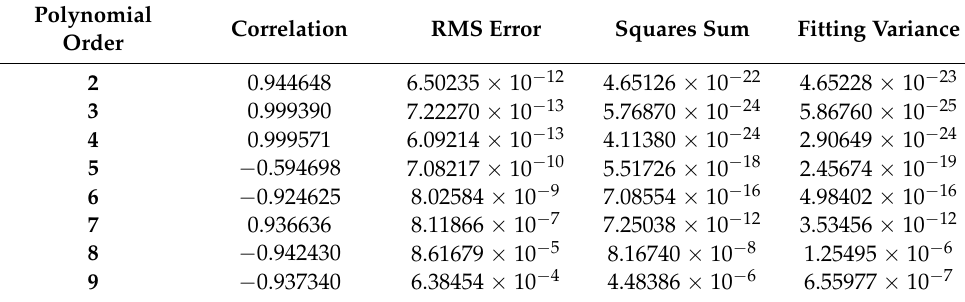
Table 1. Statistical optimization results for the polynomial response order.